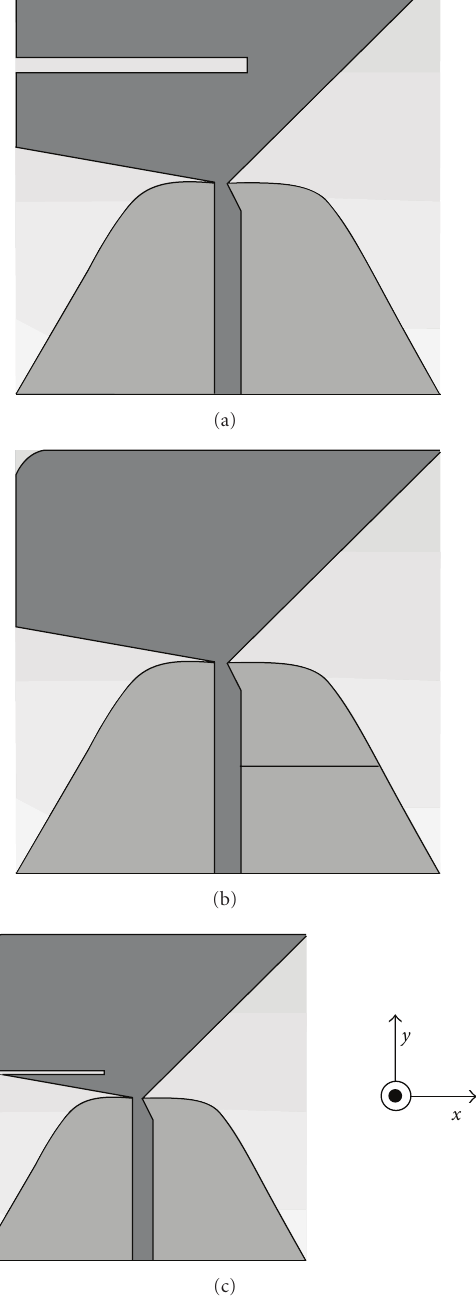
Figure 2: The geometry of the single band-notched antennas: (a) single band-notched antenna 1, (b) single band-notched antenna 2, (c) single band-notched antenna 3.